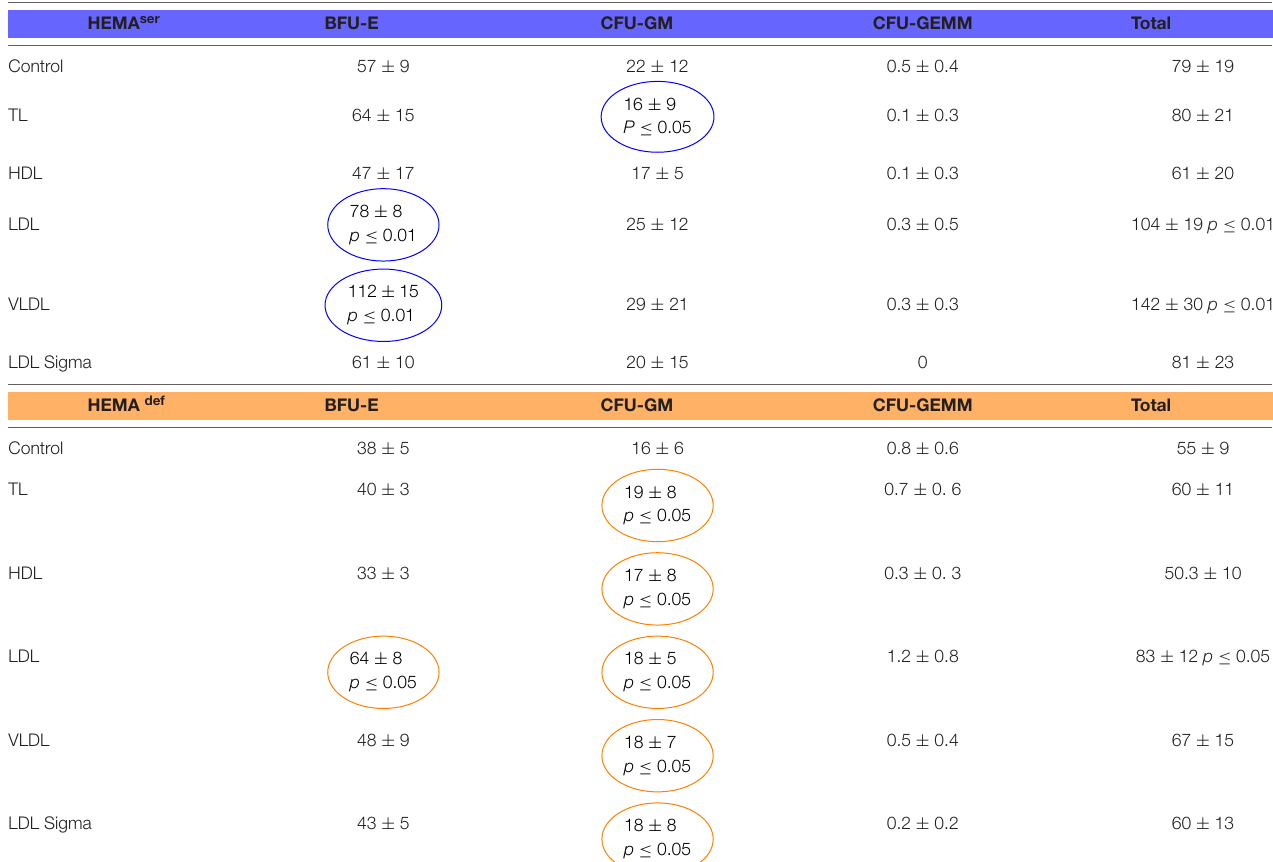
TABLE 2 | Effects of lipoproteins purified from human plasma on the number of colonies generated by human MNC in semisolid cultures under HEMA ser and HEMA def conditions. HEMA ser BFU-E CFU-GM